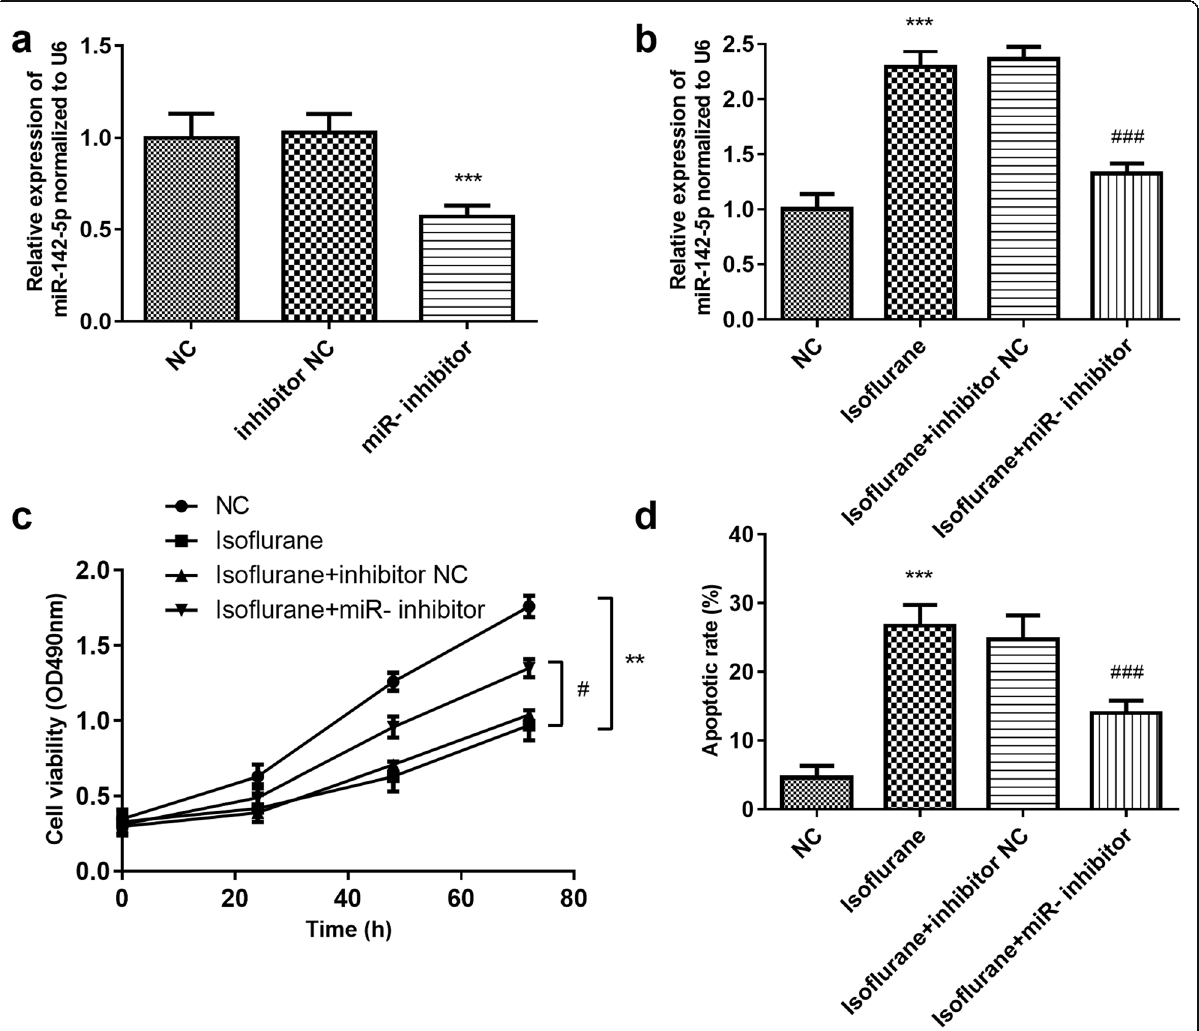
Fig. 4 The effect of miR-142-5p on hippocampal neuron cell viability and apoptosis. a MiR-142-5p inhibitor transfection significantly reduced miR- 142-5p level. b Isoflurane treatment significantly increased the expression level of miR-142-5p in hippocampal neurons, but miR-142-5p inhibitor transfection significantly reversed the effect. c MTT assay results suggested that isoflurane treatment inhibited the cell viability significantly, which was alleviated by miR-142-5p downregulation. d Flow cytometry assay results demonstrated that isoflurane treatment promoted cell apoptosis, while miR-142-5p downregulation relieved isoflurane-induced cell apoptosis. *** P < 0.001, compared with control group; # P < 0.05, ### P < 0.001, compared with isoflurane